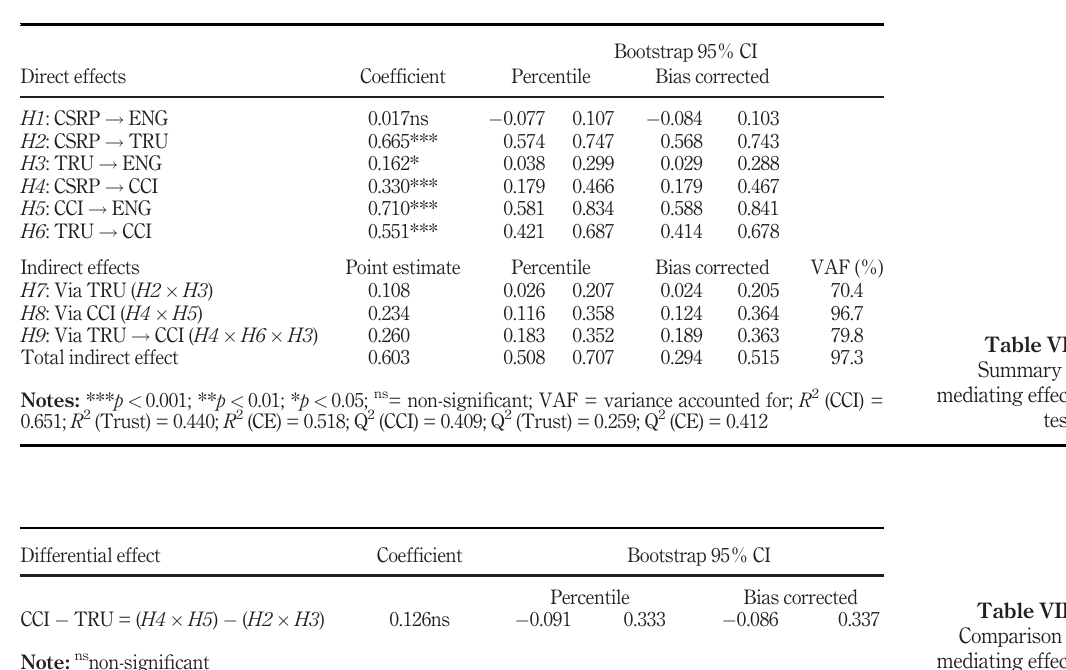
Table VIII. Comparison of